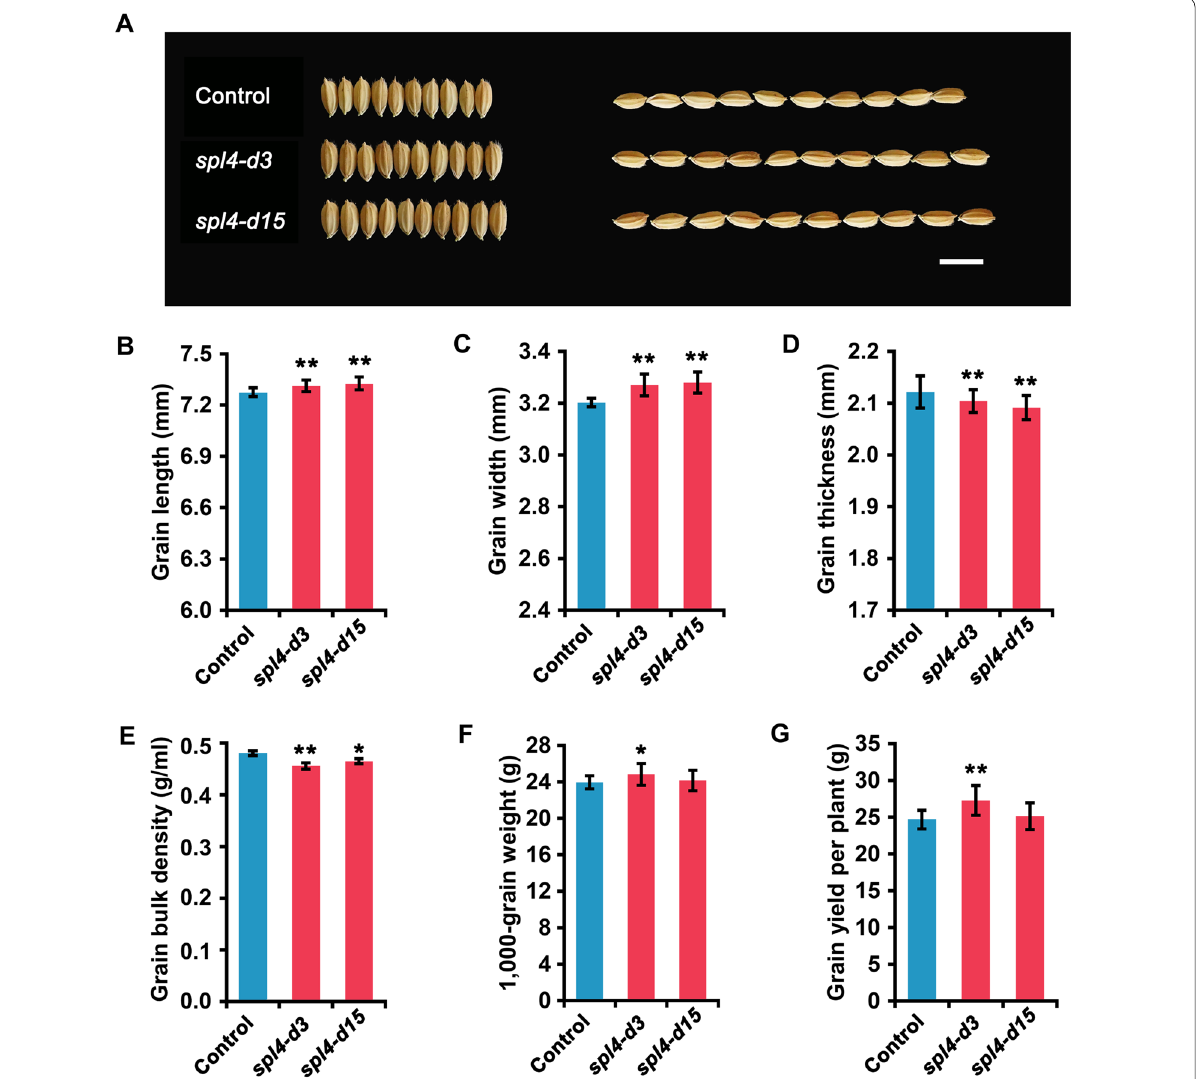
Fig. 2 Grain phenotypes of the OsSPL4 mutation transgenic lines and control plants. A Grain shapes of spl4-d3 , spl4-d15 and control plants, scale bar 1 cm. B – G Comparisons of grain size and the yield between spl4-d3 , spl4-d15 and control plants. B Grain length. C Grain width. D = Grain thickness. E Grain bulk density. F 1000-grain weight. G Grain yield per plant. Significant difference was determined by Student’s t test, * P < 0.05, ** P <